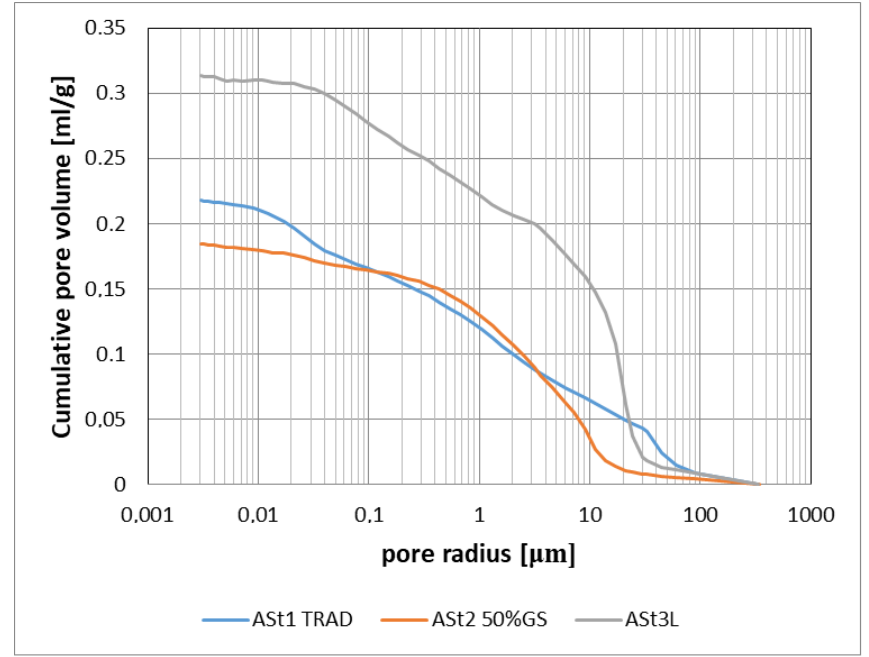
Figure 11. The cumulative volume of pores in the samples of silicate material: traditional (blue color), modified with 50% glass sand and 50% quartz sand (red color), and the material fully modified (90%) with glass sand (gray color) [78].